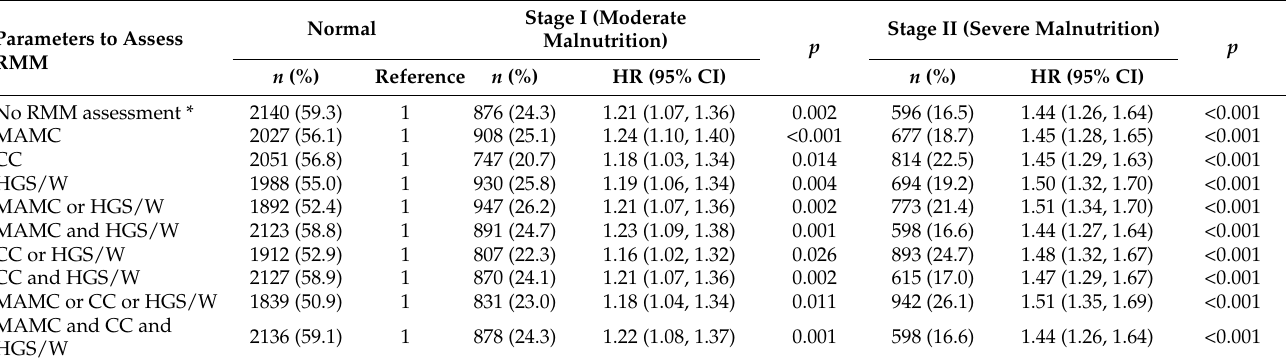
Table 2. Univariate Cox Regression Analyses of the GLIM Grade and Survival Using Different Parameters for RMM